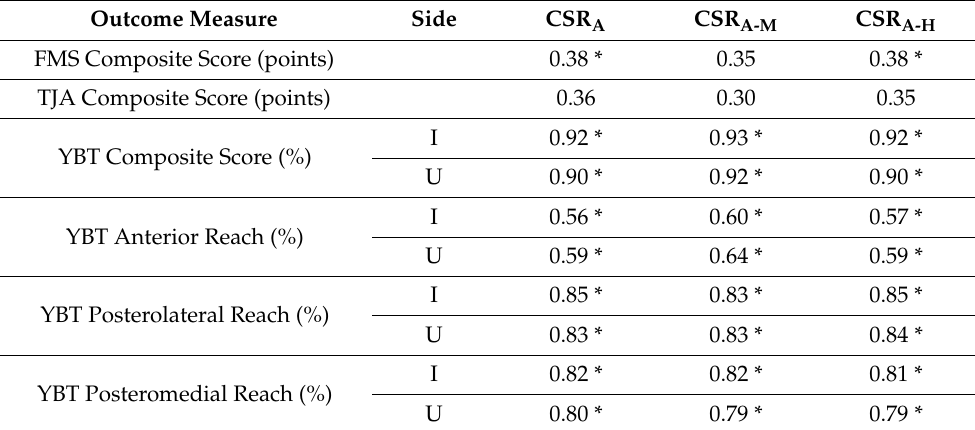
Table 2. The relationship between CSR and raw tests results.